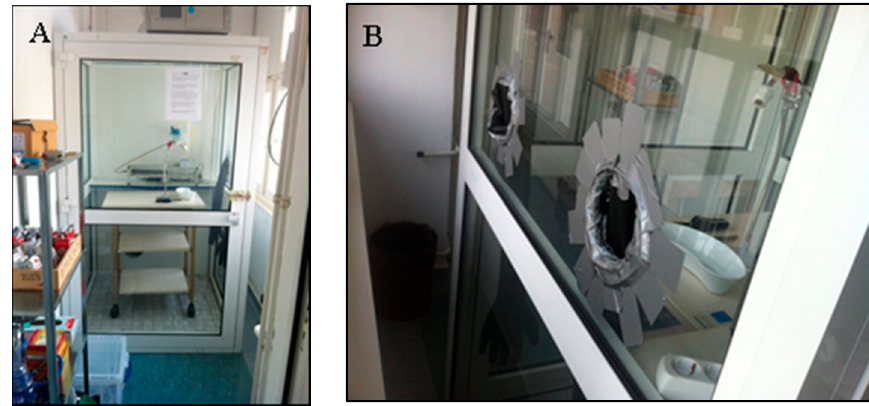
Figure 2. ( A ) The 2.88-m 3 glass ventilation chamber in an air-conditioned laboratory room; ( B ) A pair of rubber gloves in the right wall of the chamber to reduce the potential of contact as much as possible.